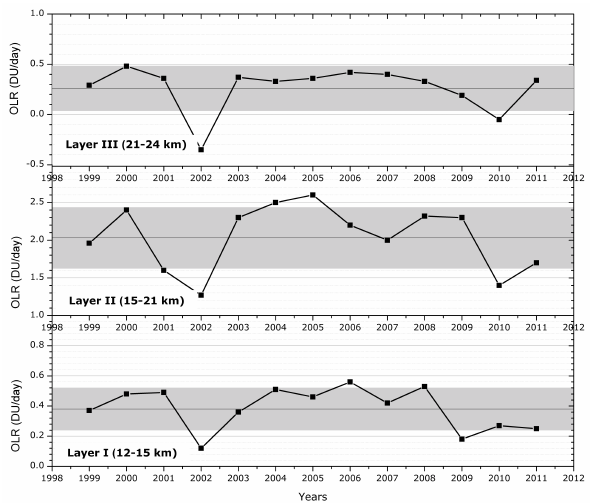
Fig. 5. Inter-annual evolution of the ozone loss rate in the layer III Figure 5. Inter-annual evolution of the ozone loss rate in the layer III 21-24 km layer (upper 4 21–24km layer (upper plot), in layer II (middle plot) and in layer I plot), in layer II (middle plot) and in layer I (lower plot) during phase II (days 220-273). Grey 5 (lower plot) during phase II (days 220–273). Grey shaded areas in- shadowed areas indicate one standard deviation. 6 dicate one standard deviation.